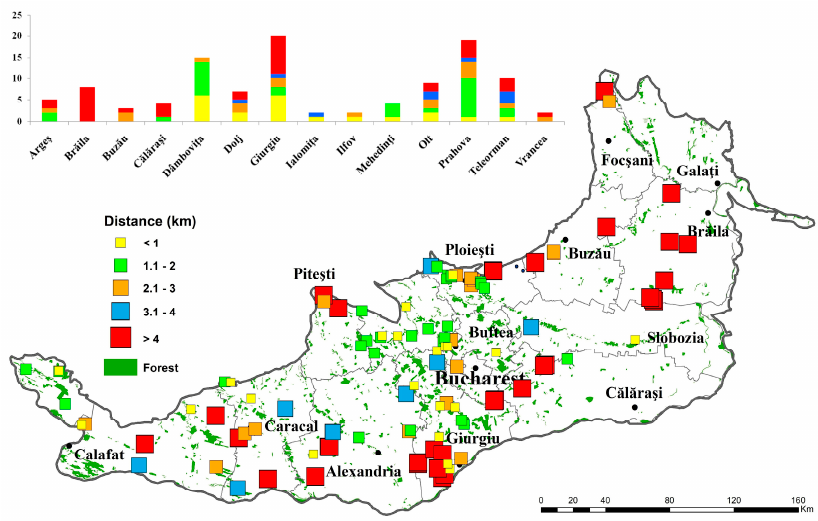
Figure 7. Distance of PV farms to forests.